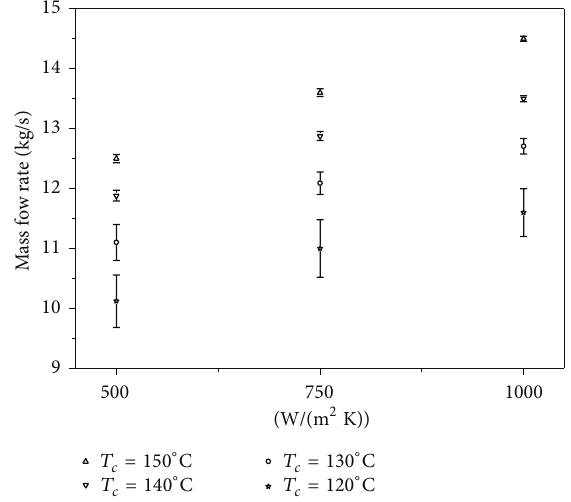
Figure 5: Mass flow rate in single phase quasisteady stage under different conditions.